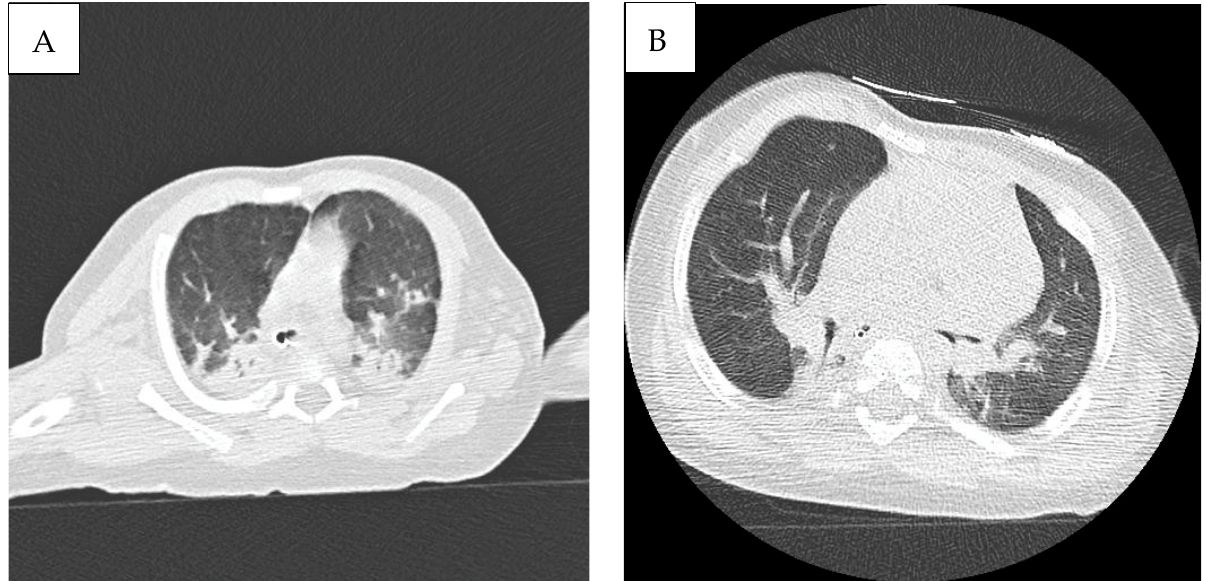
Figure 2. ( A ) High-resolution CT scan (HRCT) showing bilateral parenchymal lung consolidation, involving both superior and inferior lobes, mainly with posterior extension, associated with diffuse ground glass opacities, consistent with pulmonary lymphangiectasia/acute respiratory distress. ( B ) Follow-up chest CT showing a significant reduction in lung consolidation areas.